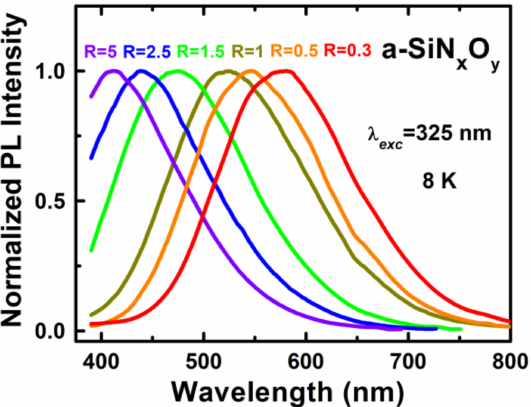
Figure 4. Normalized PL spectra of the a-SiN x O y films for various R under the excitation wavelength of 325 nm at 8 K.